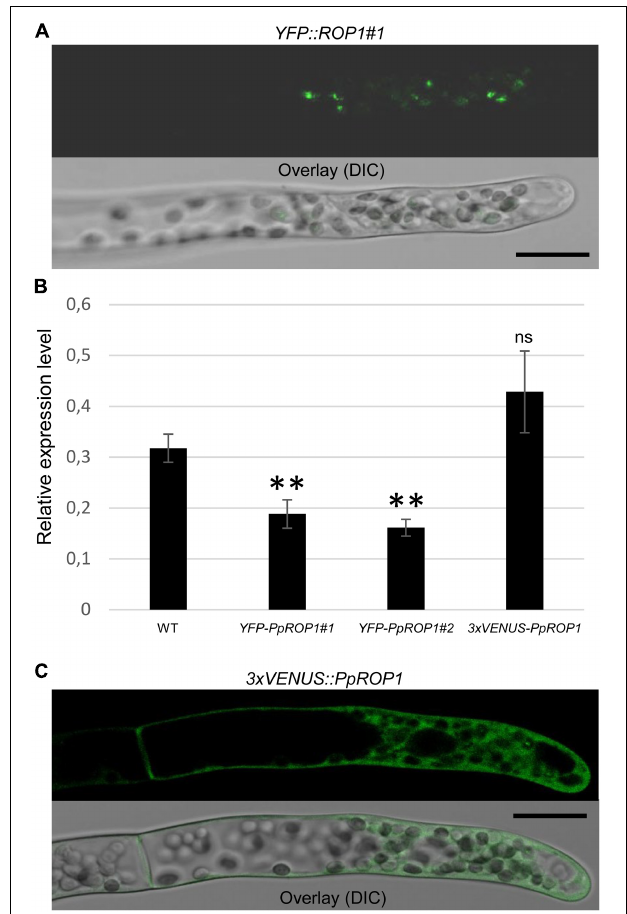
FIGURE 5 | Analysis of the intracellular distribution of fluorescent PpROP1 fusion proteins in apical cells of YFP::PpROP1 and 3xVENUS::PpROP1 “knock-in” protonemata. (A) Medial confocal optical section through the tip of a YFP::PpROP1#1 protonemal filament (upper panel). All imaged apical cells did not display detectable YFP fluorescence, but similar to WT cells ( Figure 3A ) emitted weak background chlorophyll autofluorescence ( n = 10). Overlay (lower panel): the fluorescence image shown in the upper panel overlaid onto a transmitted light reference image (differential interference contrast, DIC). Scale bar = 25 µ m. (B) PpROP1 expression levels in WT and “knock-in” ( YFP::PpROP1#1 and 2 ; 3xVENUS::PpROP1 ) protonemata as determined by qPCR. Relative expression levels are indicated, which represent absolute PpROP1 transcript levels normalized relative to the absolute transcript level of the reference gene UbC-E2 . The statistical significance of differences between WT and other data sets was assessed using ANOVA (Bonferroni-Holm, one factor). ∗∗ P < 0.01; ns: not significantly different. Error bars: standard deviation. (C) Medial confocal optical section through the tip of a 3xVENUS::PpROP1 protonemal filament (upper panel). Only diffuse cytoplasmic 3xVENUS::PpROP1 fluorescence is visible. All imaged apical cells displayed essentially identical 3xVENUS::PpROP1 distribution patterns ( n = 10). Overlay (lower panel): the fluorescence image shown in the upper panel overlaid onto a transmitted light reference image (differential interference contrast, DIC). Scale bar = 25 µ